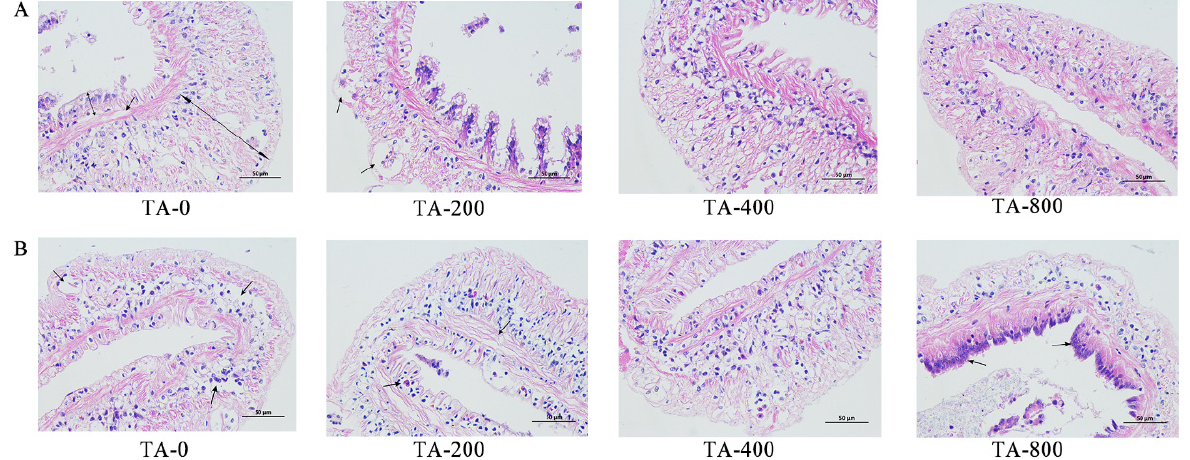
Figure 3. Intestine histology of L. vannamei at the feeding trial after 56 days and ammonia stress after 48 h. ( A ) The feeding trial lasted 56 days; ( B ) ammonia stress lasted for 48 h. Whole segments were marked with H&E. Scale bar: 50 µ m. The arrows in the figure indicate the differences between the treatment groups.